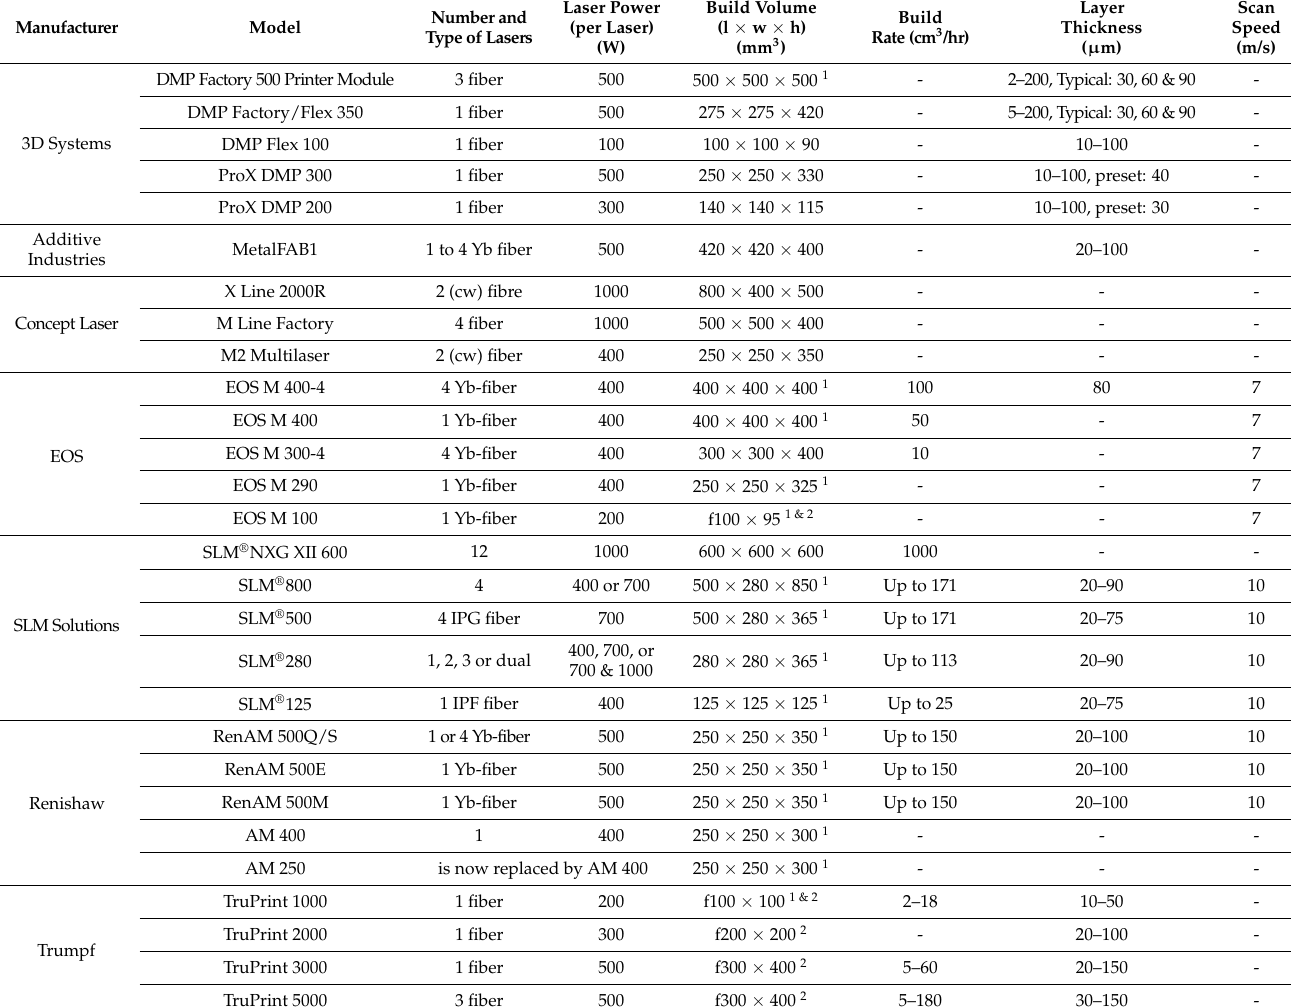
Table 1. The features of the current L-PBF machines